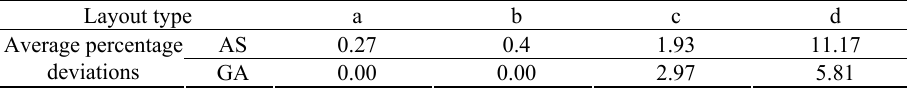
Table 6. The average % deviation from LB due to the machine layout types Layout